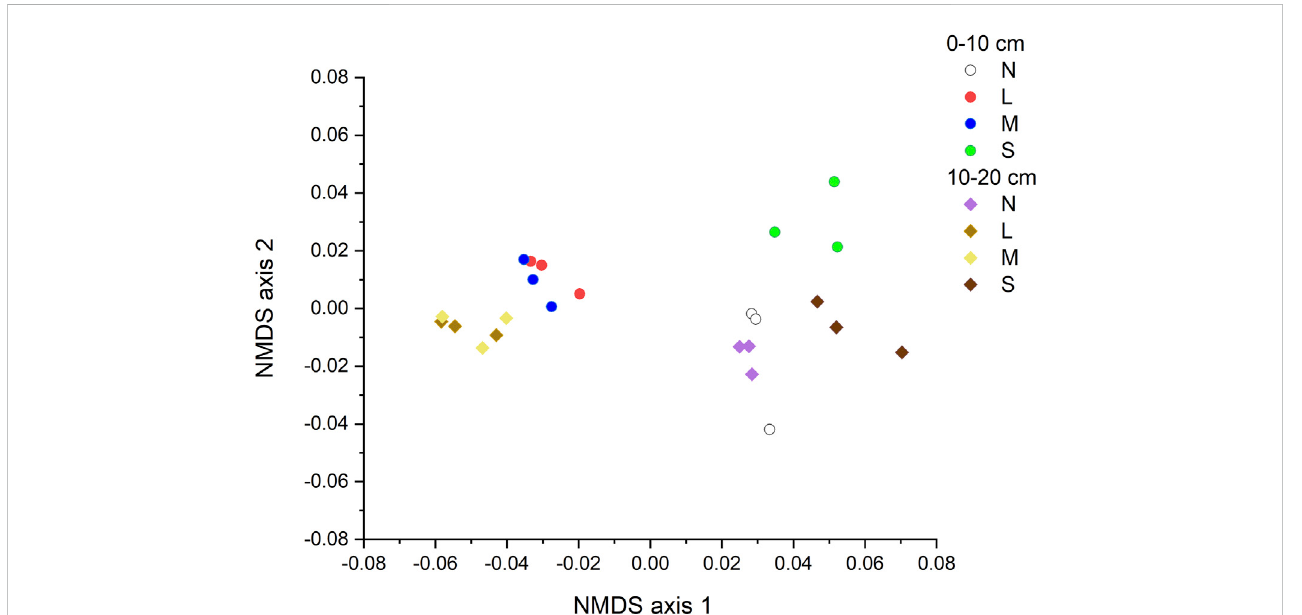
FIGURE 2 NMDS showing communities structures of CAZyme families under various degradation severities and soil depth. N: non-degraded; L: lightly degraded; M: moderately degraded; S: severely degraded.